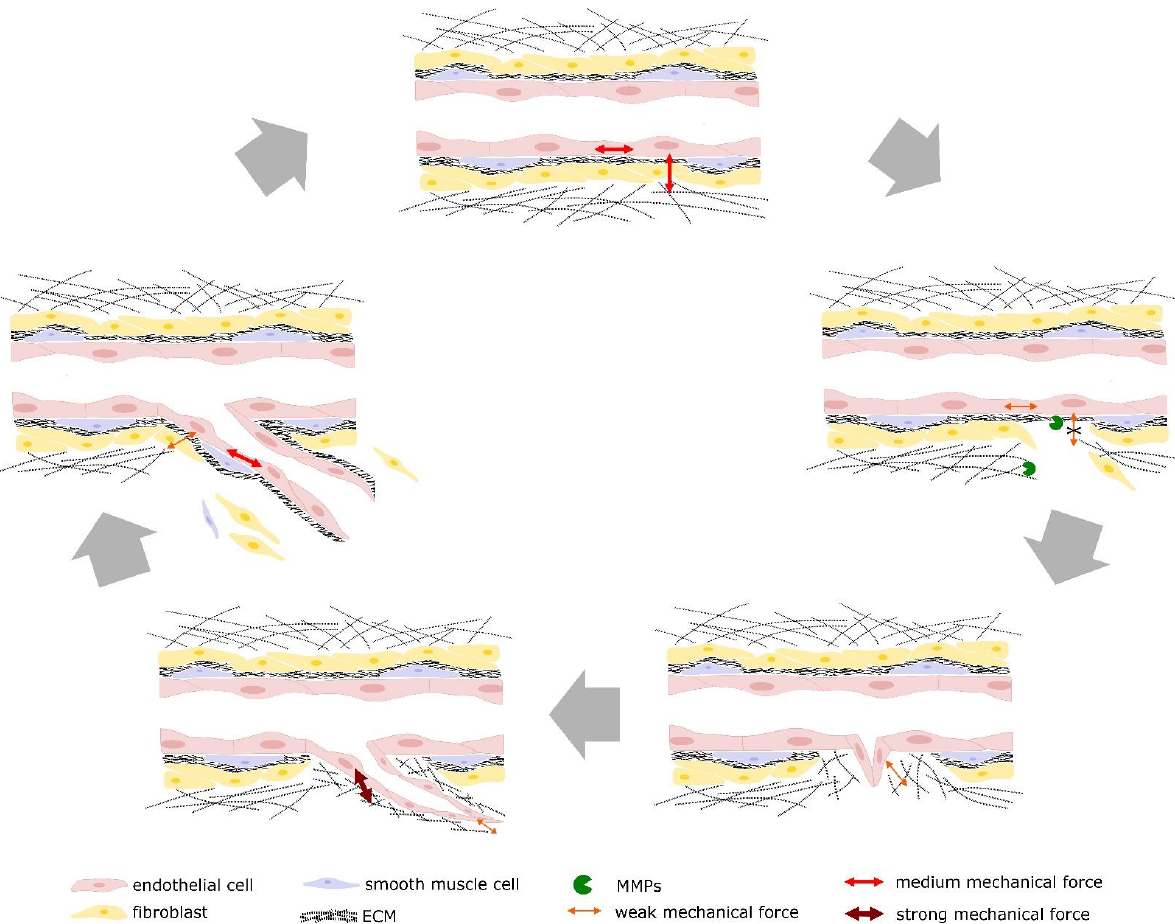
Figure 3. Mechanical forces during angiogenesis. Weak, medium, and strong mechanical forces acting on the ECs from the ECs or between the ECs during the different steps of angiogenesis.